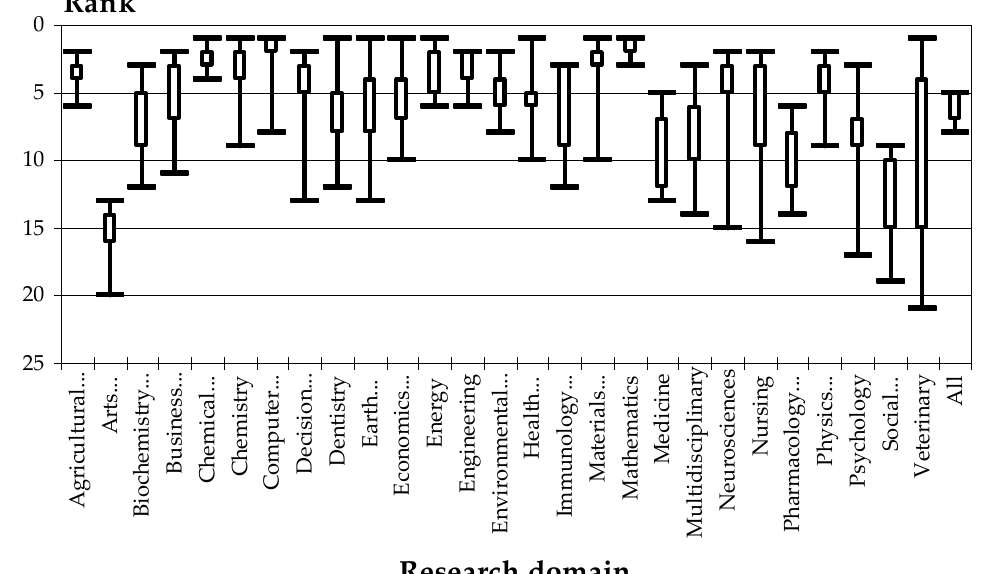
Figure 10. The visibility of articles published in different fields in Slovenia during 2010–2018, measured based on the adjusted number of citations per document. The figure displays boxplots based on the ranks of the fields computed for each year separately. Results indicate a huge variability and pinpoint a poorer performance in arts and humanities and social sciences.